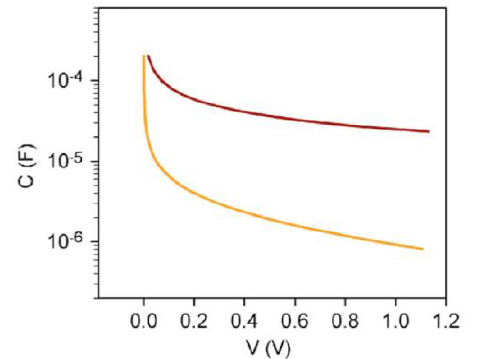
Figure 11. Simulation result of capacitance vs barrier voltage (adopted from Ref.